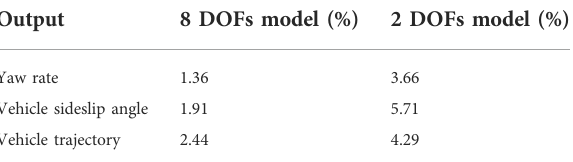
TABLE 2 MAPE of the established models.